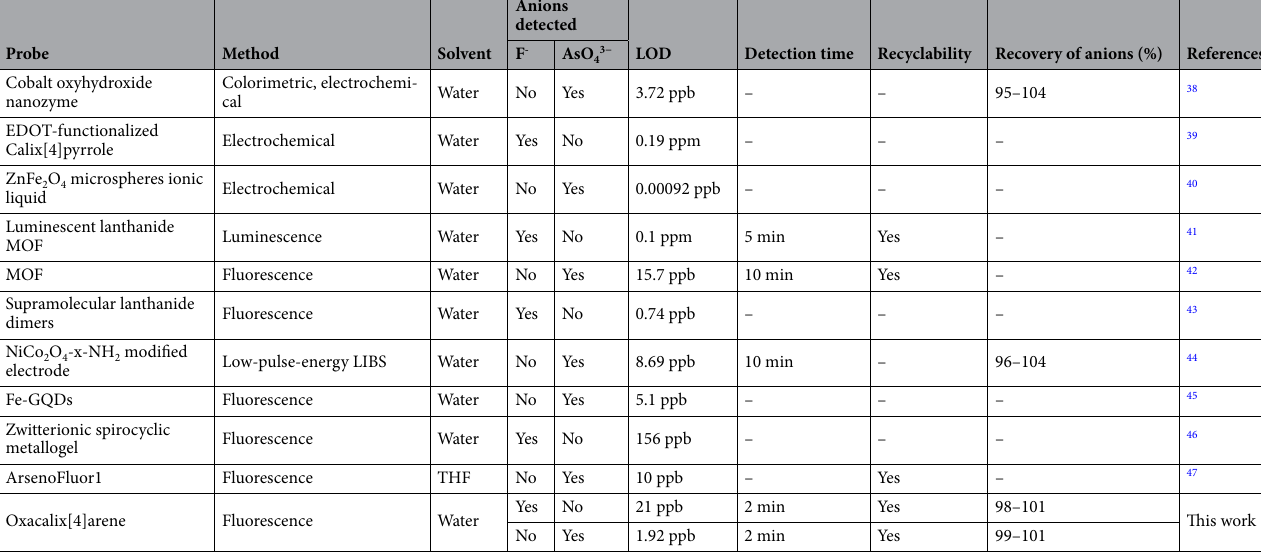
Table 1. Comparison between some recently reported probes and their sensitivity towards fluoride and arsenate.